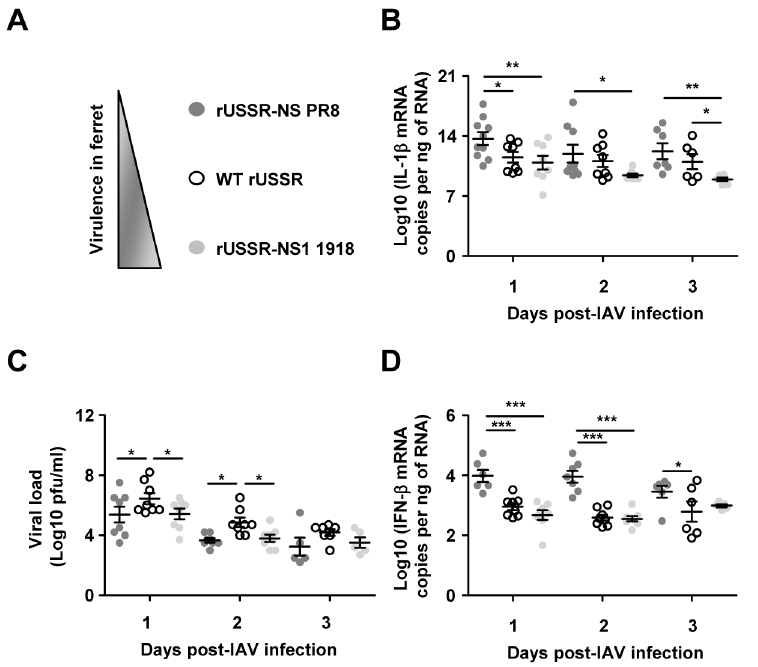
Figure 5. 1918 NS1 inhibits IL-1 b response and type I IFN response, and results in higher virulence invivo in ferrets. (A) Schematic representation of pathogenesis upon infection with rUSSR-NS1 1918, rUSSR-NS PR8, or WT rUSSR, as previously described [20]. (B) Kinetics of IL-1 b mRNA response to rUSSR-NS PR8 ( n =10), WT rUSSR ( n =8), and rUSSR-NS1 1918 ( n =8) in cells from nasal wash of infected ferrets at days 1, 2, and 3 post-infection. (C) Viral load in nasal wash from the same ferrets as in (B) presented as a log10 of pfu/ml. (D) Kinetics of IFN- b mRNA response to rUSSR-NS PR8, WT rUSSR, and rUSSR-NS1 1918 under the same experimental conditions as (B). (B and D) Data presented as a log10 of IL-1 b or IFN- b mRNA copy number per nanogram of RNA with mean 6 SEM: calculated from a standard curve generated from in vitro –transcribed mRNA of known concentration. * p , 0.05, ** p , 0.01, and *** p , 0.001.